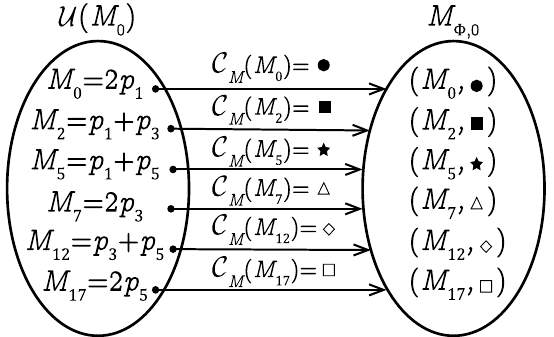
Figure 6. The initial state M (cid:31) ,0 of the observer